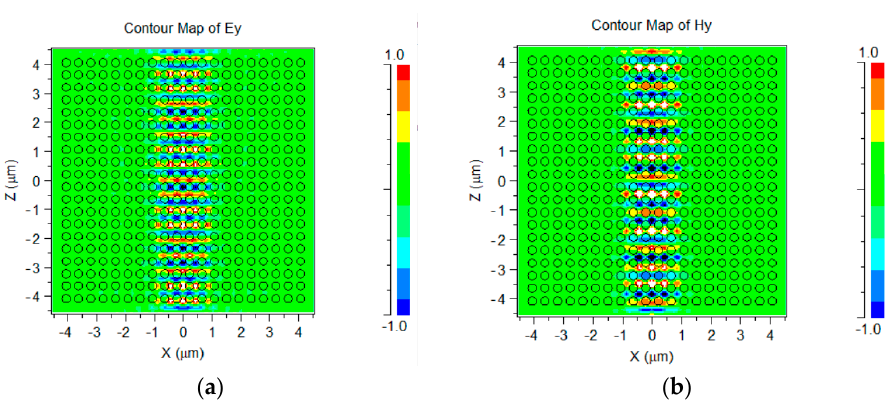
Figure 3. ( a ) EFC diagram in TE mode; ( b ) EFC diagram in TM mode.